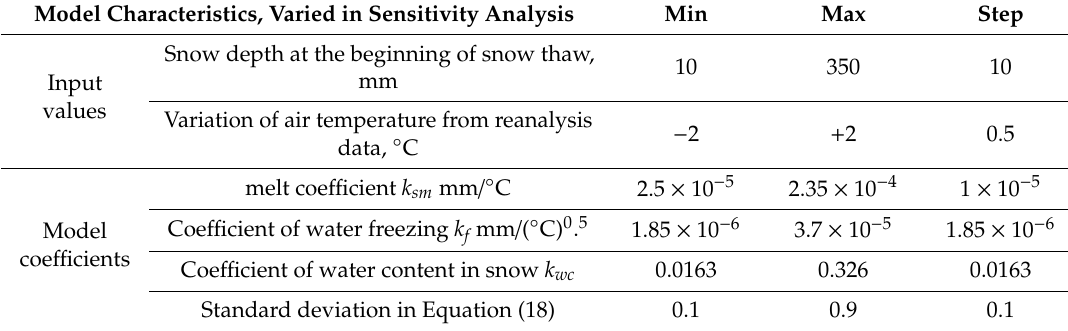
Table 1. Range of temporal variation of model characteristics used in sensitivity analysis. The number of numerical experiments n = 1 + (Max − Min) / Step. Model Characteristics, Varied in Sensitivity